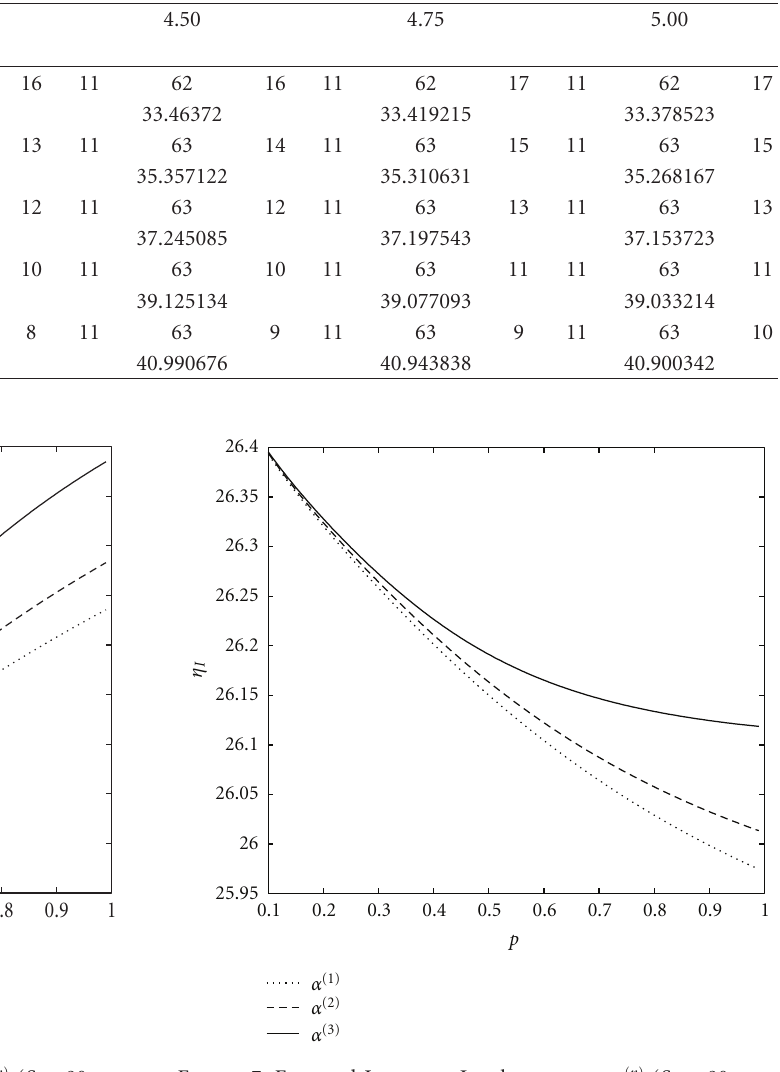
Figure 7: Expected Inventory Level— p versus α ( n ) ( S = 90, s = 15, N = 25, λ = 8, β = 1 . 4, γ = 0 . 7, μ = 0 . 8 .